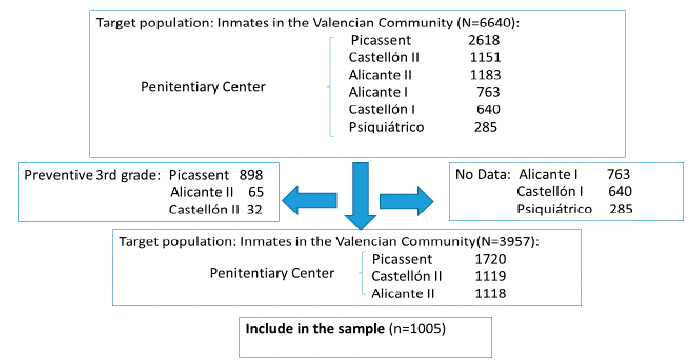
Figure 1. Sample Figure 1. Sample selection.